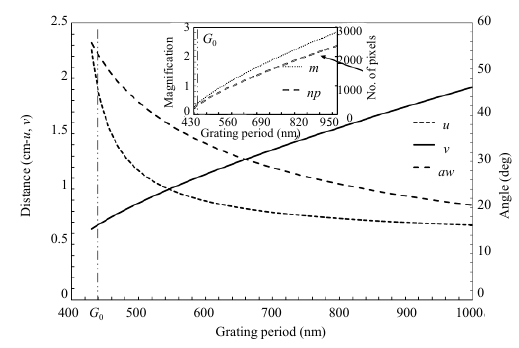
Fig. 7 Relation between angular width aw , object distance u , image distance v , magnification m and number of pixels np , for grating period from 430 nm–1000 nm with the incident angle of 50 ˚ .